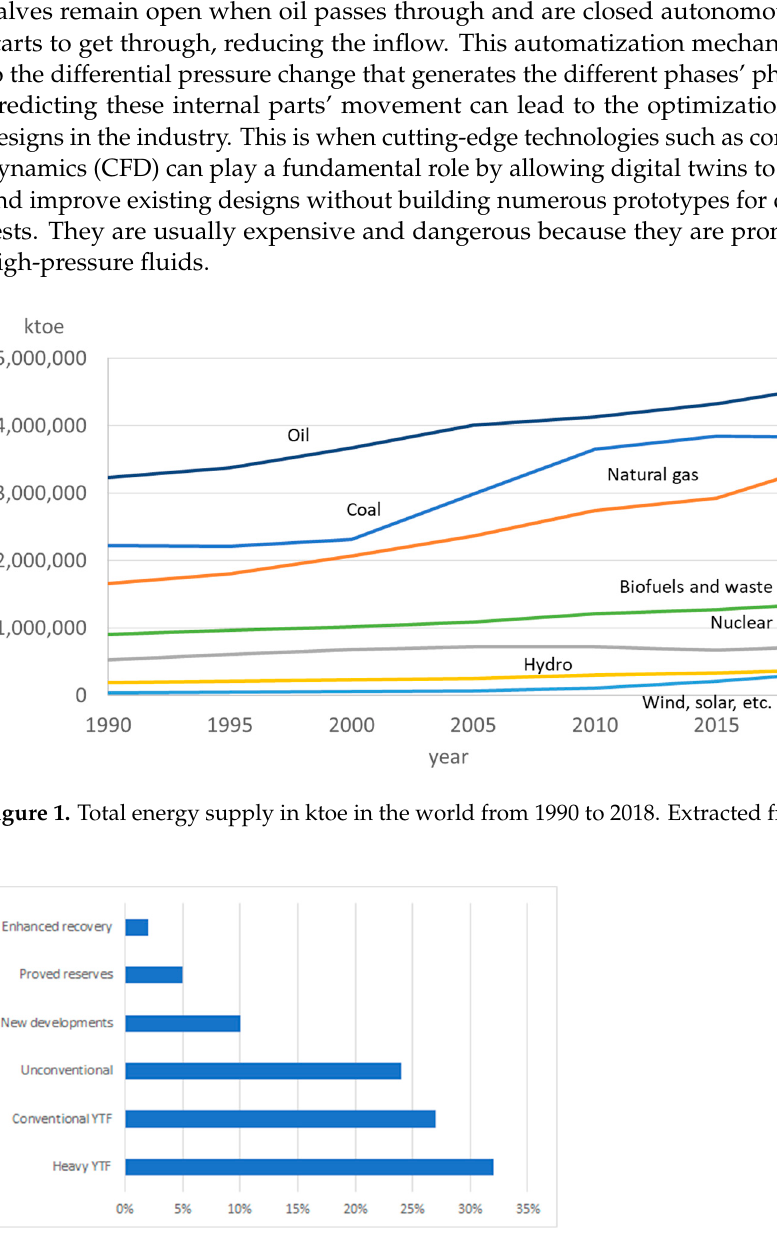
Figure 2. Distribution of methods used for oil production in Colombia. Extracted from Agencia Nacional Hidrocarburos [2].